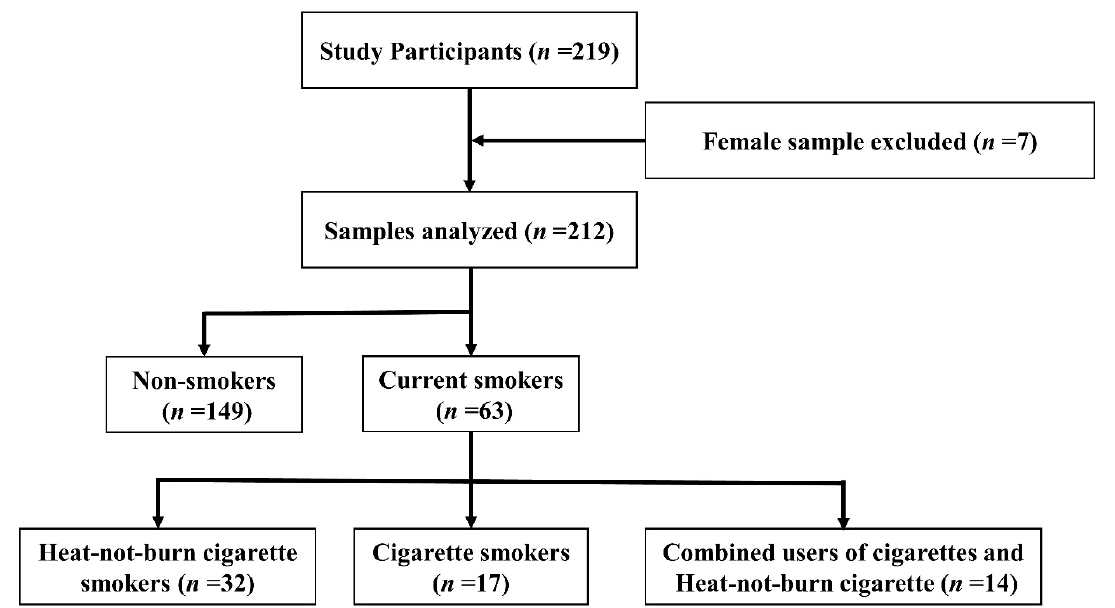
Figure 1. Flowchart in this study. 212 participants were included in this study, which comprised 32 HNB cigarette smokers, 17 paper cigarette smokers, 14 combined HNB and paper cigarette smokers, and 149 non-smokers.